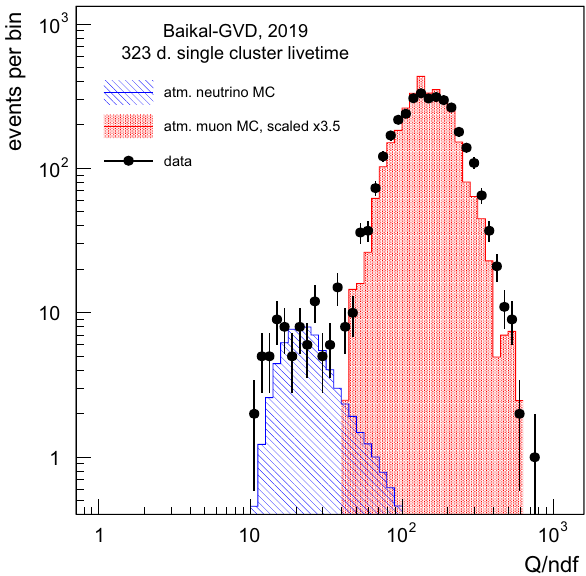
Fig. 3 Distribution of the fit quality parameter for tracks reconstructed as upward-going with cos θ < − 0 . 5. The Baikal-GVD data are shown by black points with statistical error bars. The MC predictions for atmo- spheric muons (scaled by a factor 3.5) and atmospheric neutrinos (not scaled) are shown in red and blue,